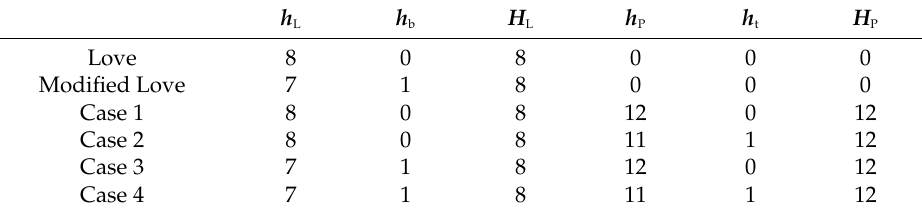
Table 3. Geometries of the four configurations, whose dispersion relations are given in Figure